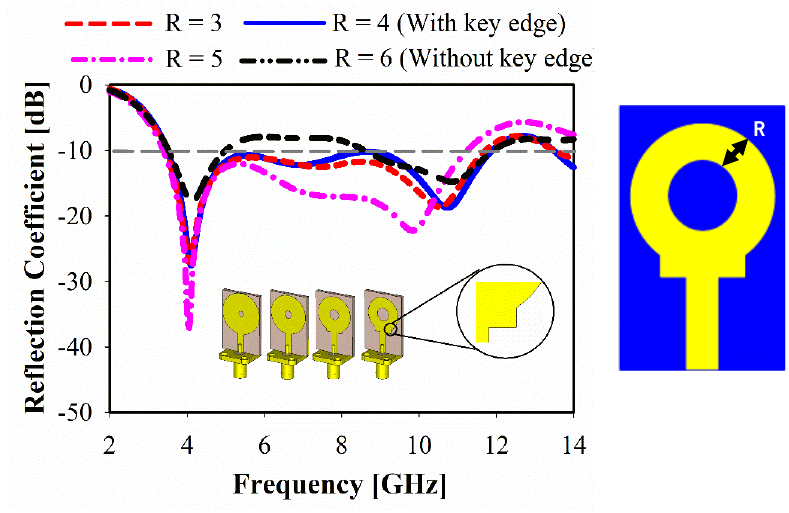
Figure 10. Simulated reflection coefficient for ring radiator line-width R.